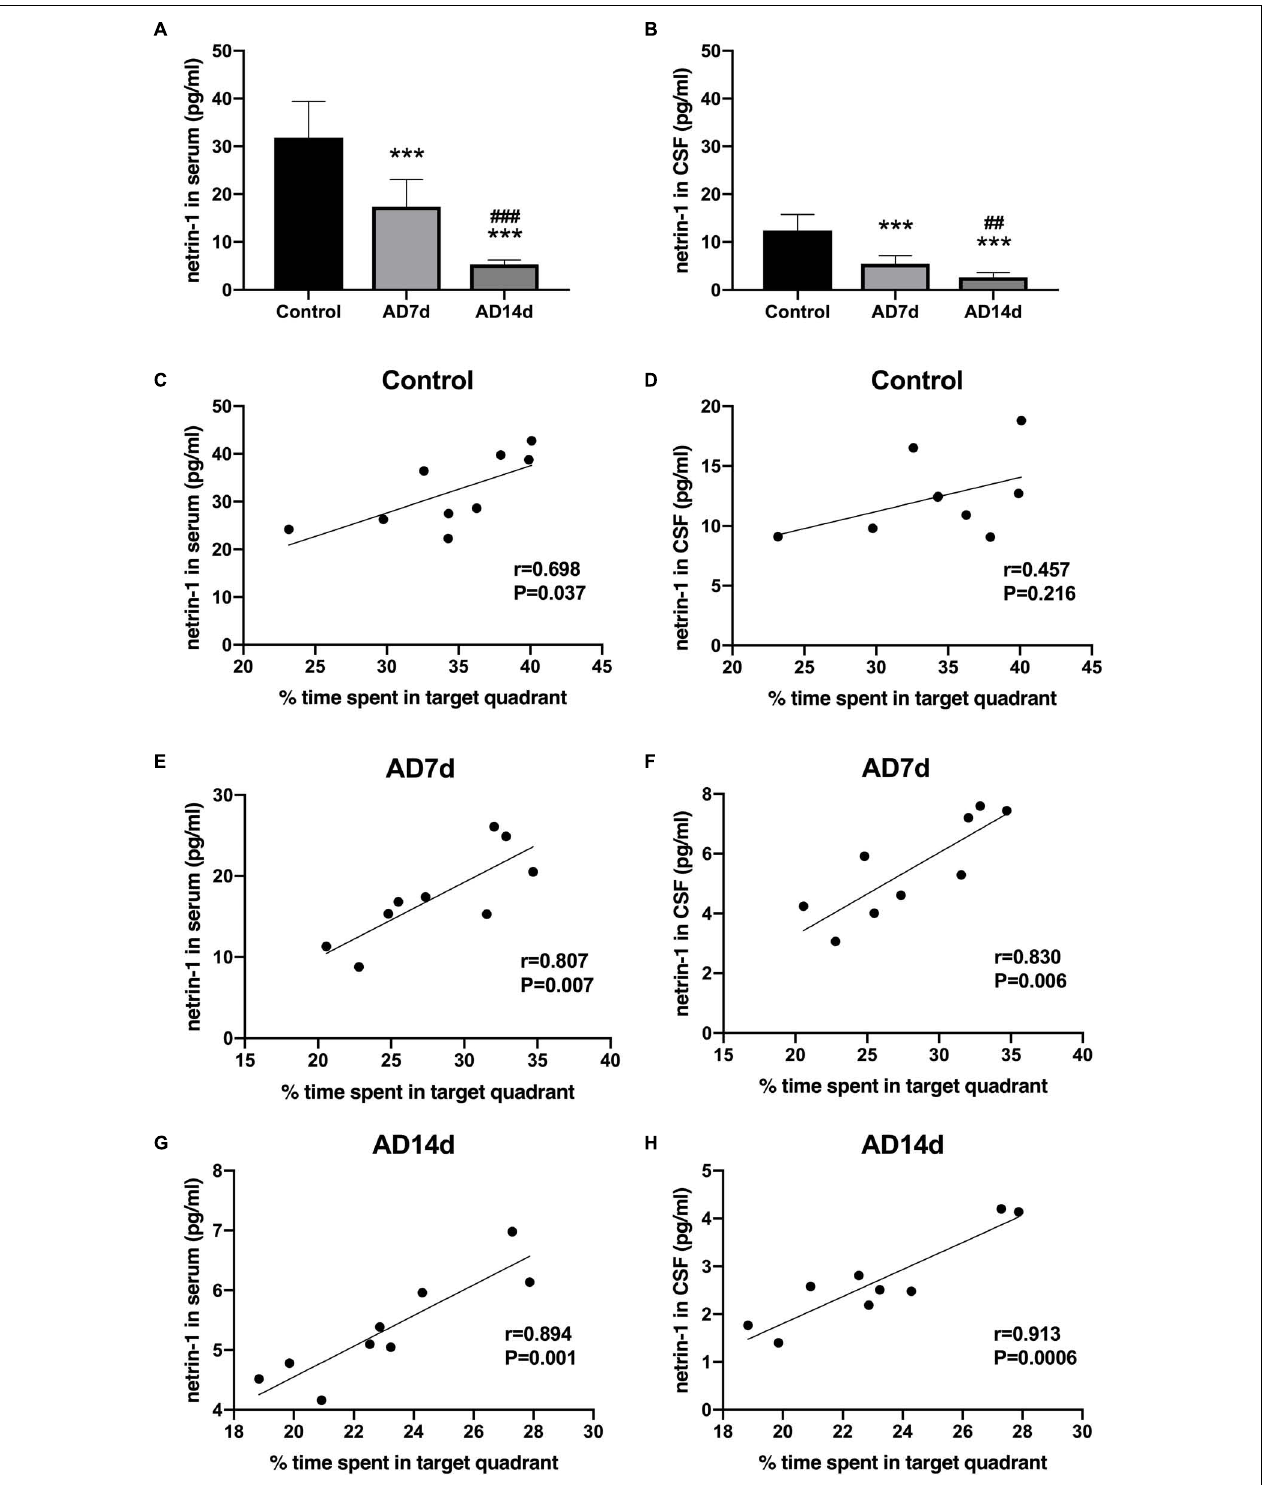
FIGURE 3 | Down-regulation of netrin-1 in the serum and CSF of AD rats. Netrin-1 concentrations in the serum (A) and CSF (B) of the Control, AD7d and AD14d groups were determined with use of ELISA. n = 9 per group, mean ± standard deviation, ∗∗∗ P < 0.001 vs. Control group, ## P < 0.01, ### P < 0.001 vs. AD7d group. Positive correlations were obtained between serum netrin-1 concentrations and percent of time in the target quadrant in the Control (C) , AD7d (E) , and AD14d (G) groups. Positive correlations were obtained between CSF netrin-1 concentrations and percent of time in the target quadrant in the Control (D) , AD7d (F) , and AD14d (H)